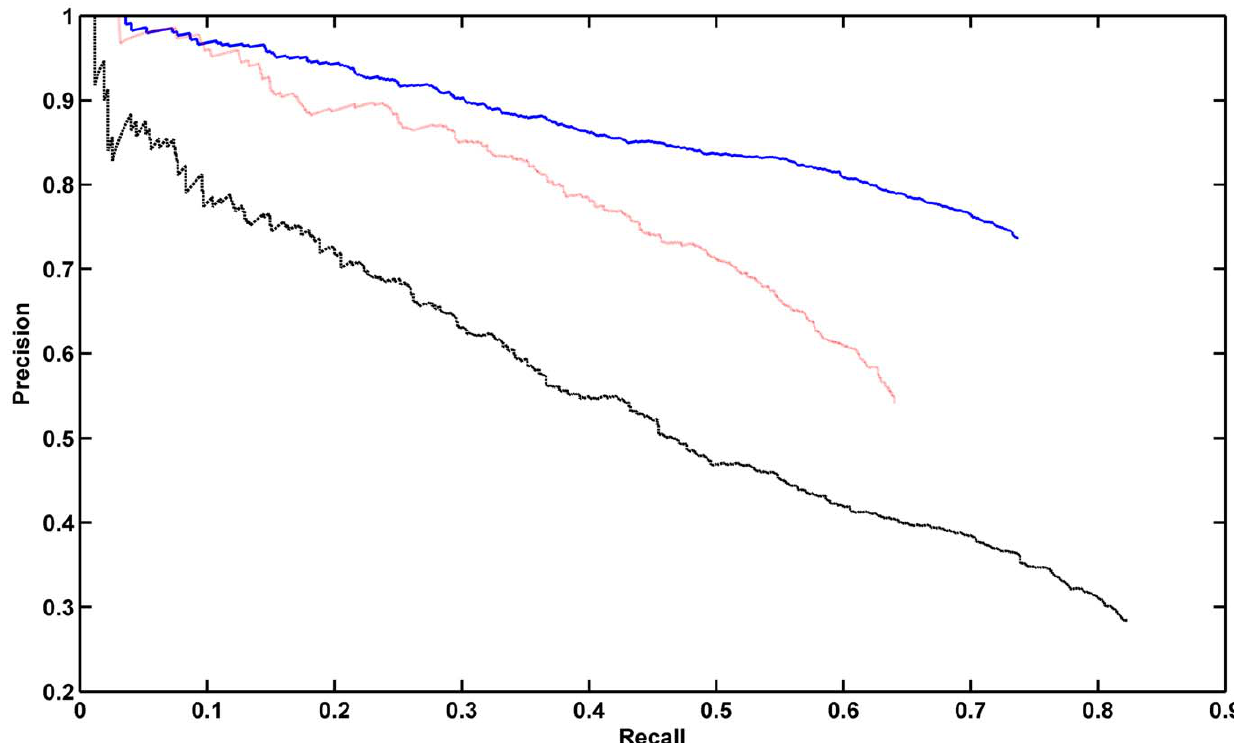
Figure 6. Precision-recall curves for protein annotations for single and multi-class classifiers. For the solid blue and dashed black line, we predicted the annotations of single pattern and mixed pattern proteins used a classifier trained with only single pattern proteins. For the solid blue line, annotations were considered correct if one of the annotations of one protein was predicted. For the dashed black line, only recognition of single pattern proteins was considered correct. For the dotted red line, a classifier trained on both single and mixed pattern proteins was used, but only the accuracy of recognizing single pattern proteins was assessed.